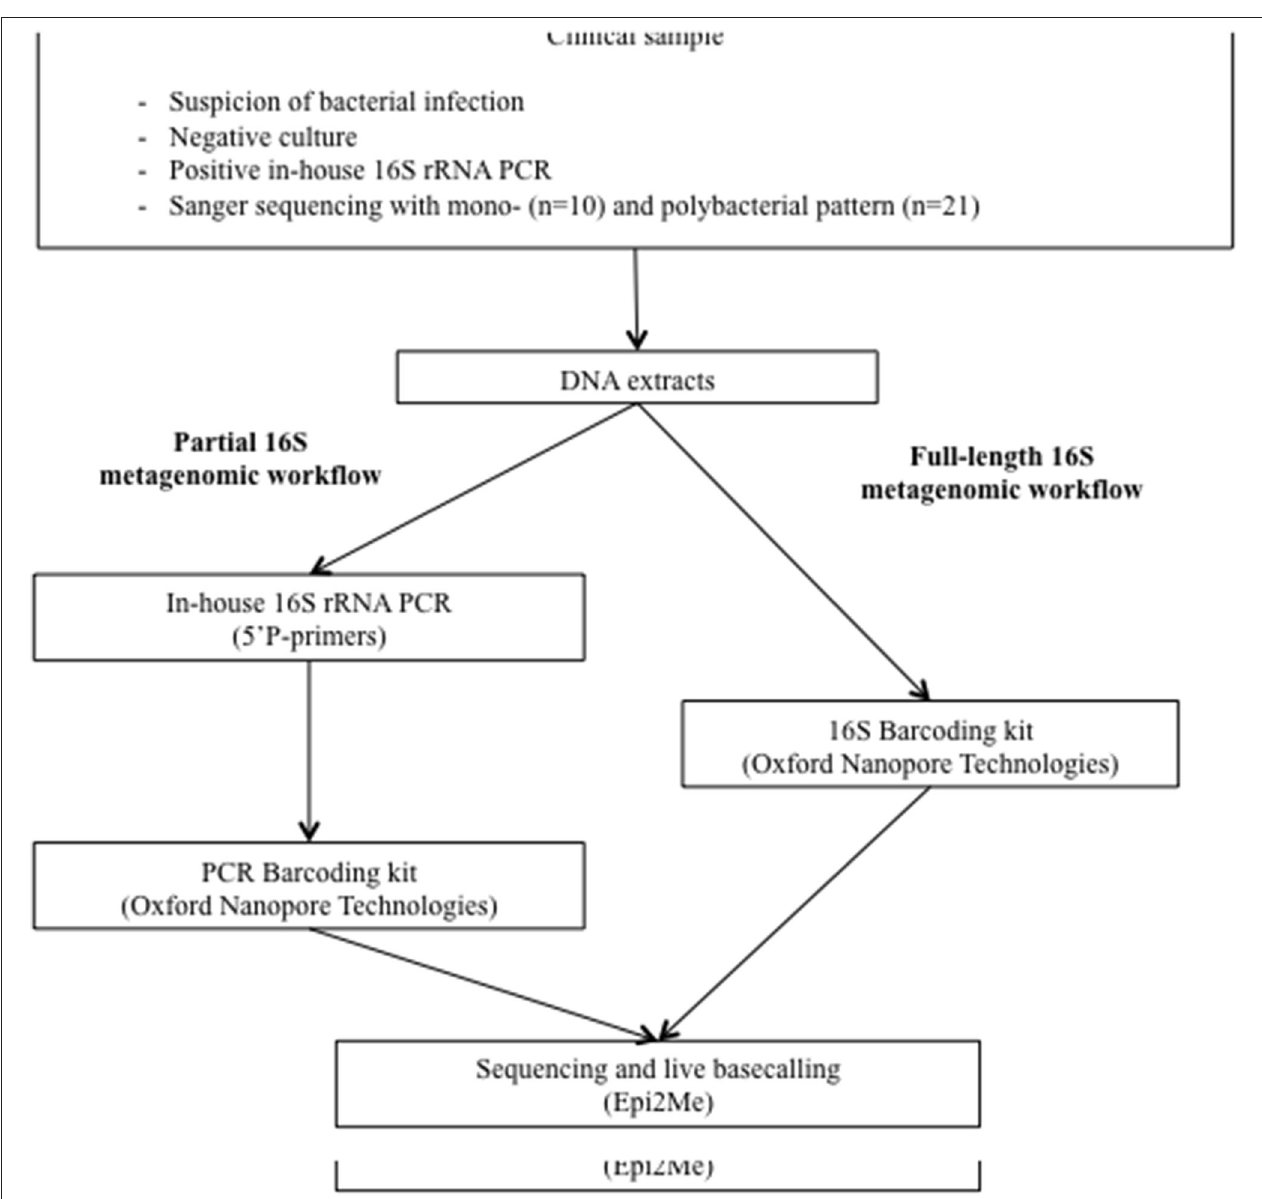
FIGURE 1 | Study design. On a routine basis, culture-negative clinical samples for which infection is suspected are sent to the molecular diagnosis platform for an in-house amplification of a portion of the 16S rRNA gene followed by Sanger-based sequencing. In the present study, DNA extracts were re-tested for (i) partial and, (ii) full-length 16S rRNA metagenomic analysis with Nanopore